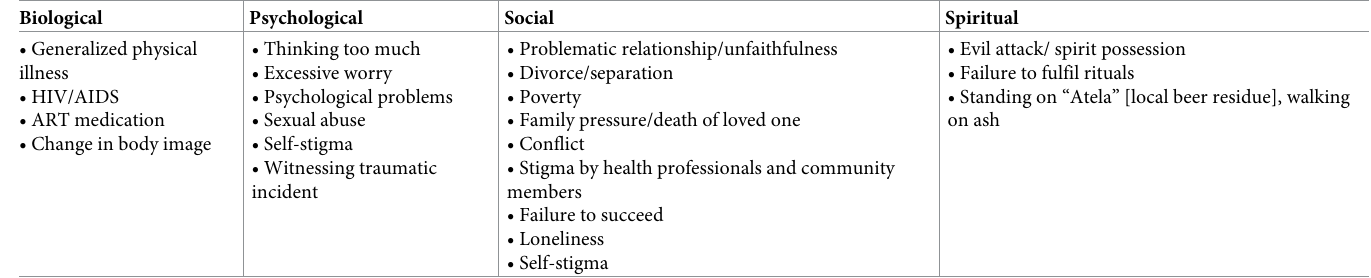
toms could be linked with different problems including HIV , imprisonment and any more problems . . . . Sadness , hopelessness and suicidal ideation appears when multiple problems are occurring on person ” A few participants reported that mental health professionals call depression differently, that is ‘Medebet’ [similar meaning for depression]. AS1 : “In general , I call it ‘Dibirt’ [depression] but there are people (mental health profession- als) who call it ‘Medebet’ ”. Perceived causes of depression. The perceived causes of depression reported by study participants included biological, psychological, social and spiritual elements (see Table 2). Table 2. Perceived causes of depression among PLWHA using biopsychosocial-spiritual model.